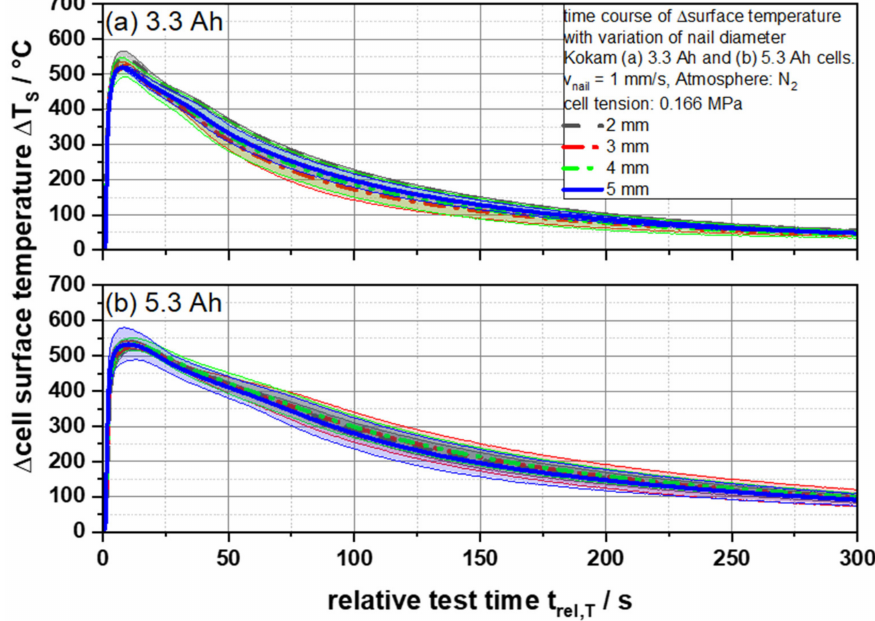
Figure 3. Average cell surface temperatures ∆ T S as a function of the relative test time t rel,T of ( a ) 3.3 and ( b ) 5.3 Ah cells for different nail geometries from 2 to 5